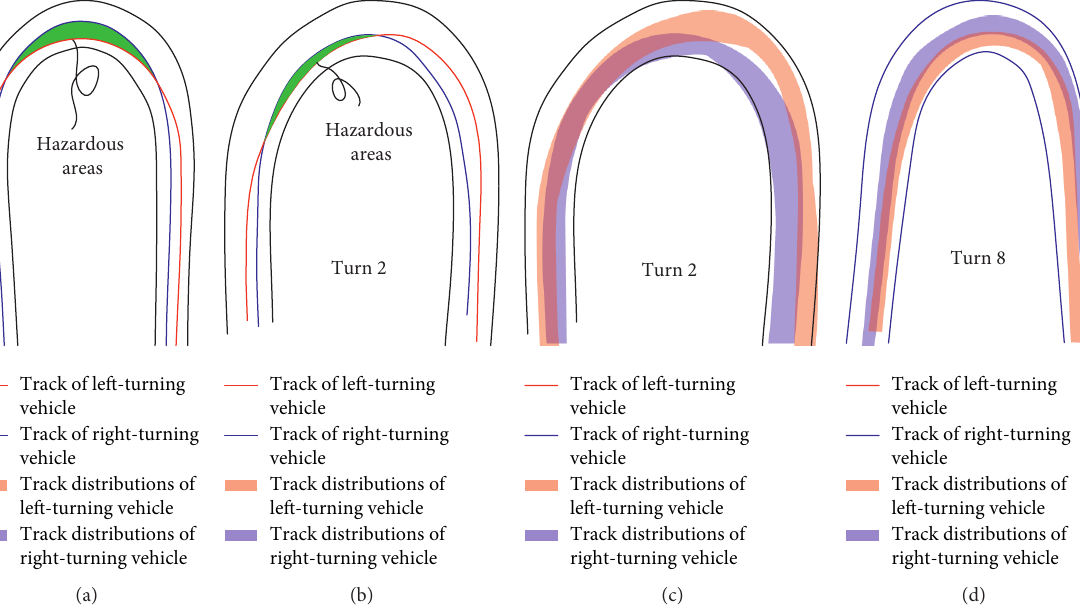
Figure 10: The interweave behavior of vehicle track in different directions. (a, b) Intertwining and interference between left-turning tracks and right-turning tracks and (c, d) intertwining between vehicle tracks in opposite lanes in hairpin-turn road